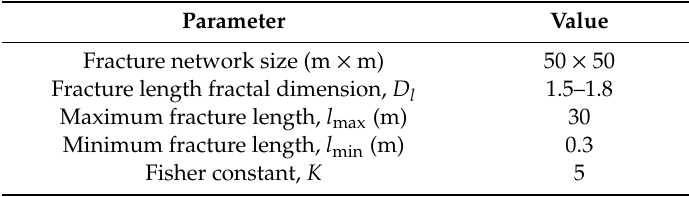
Table 1. Parameters used in creation of fractal fracture network